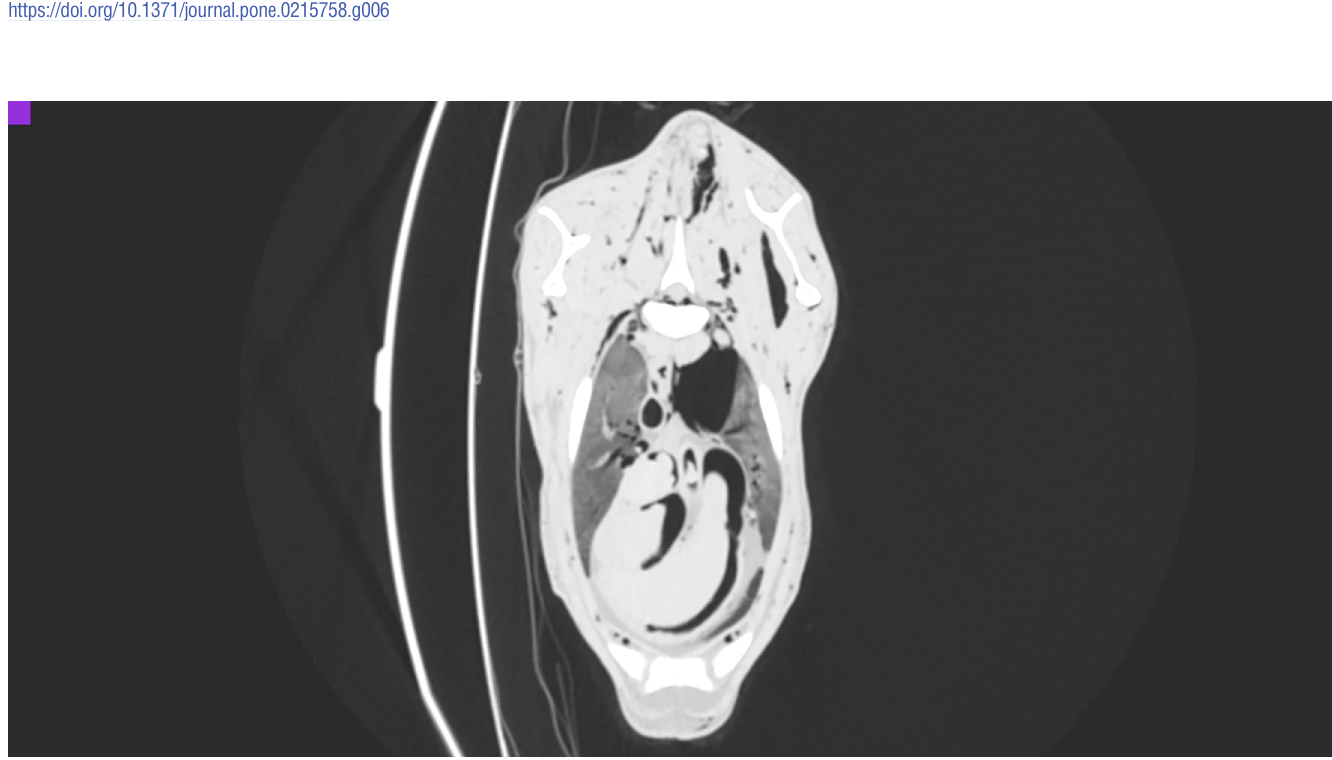
Fig 7. CT reconstruction in transverse plane at the level of the 3rd thoracic vertebra after intra-arterial air inflation; lung window. Air-filled blood vessels and heart chambers visible. Furthermore, subcutaneous emphysema in the region of withers and left pneumothorax due to air efflux from the vessels.